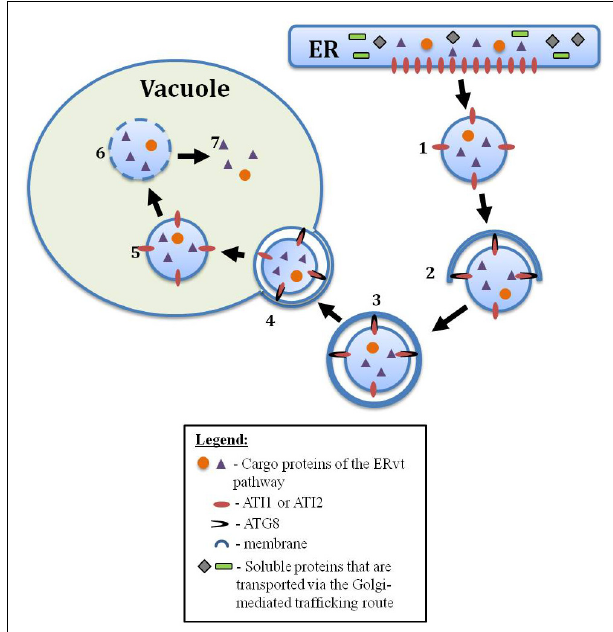
FIGURE 1 |A postulated model of the ERvt pathway in plants. (1) An ERvt body, containing vacuole destined proteins (purple triangles/orange circles) such as storage proteins or proteases, buds from the ER. (2) with the aid of special cargo receptors (such as ATI1 and 2) that interact with Atg8, the ERvt body will be attached to an isolation membrane (phagophore), and (3) will be engulfed by this expanding membrane to form a special type of ERvt autophagosome. (4)This ERvt autophagosome will fuse with the tonoplast (5) releasing the ERvt body into the vacuole as an autophagic body (6) for its subsequent degradation, and (7) incorporation of the cargo proteins to the